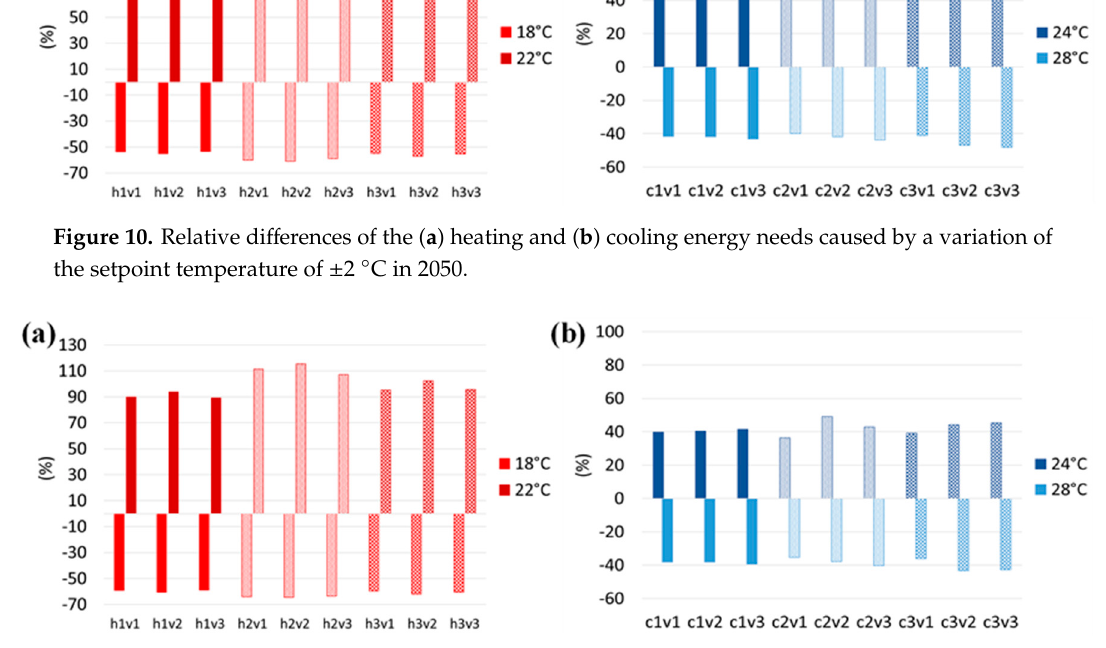
Figure 10. Relative differences of the ( a ) heating and ( b ) cooling energy needs caused by a variation of the setpoint temperature of ±2 °C in 2050.